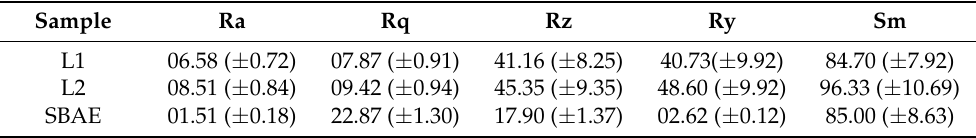
Table 1. The Ra, Rq, Rz, Ry, and Sm profilometric values of L1, L2, and SBAE titanium surfaces are reported in